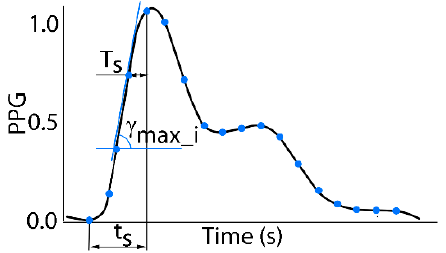
Figure 11. Estimation of SBP ei = K ∙ tan ( g max_i ) ∙ t s , where t s is the duration of the rising edge, T s is the sampling period, g max_i is the maximum steepness of the rising edge, K = SBP m / tan ( g max_i ) ∙ t s , and SBP m